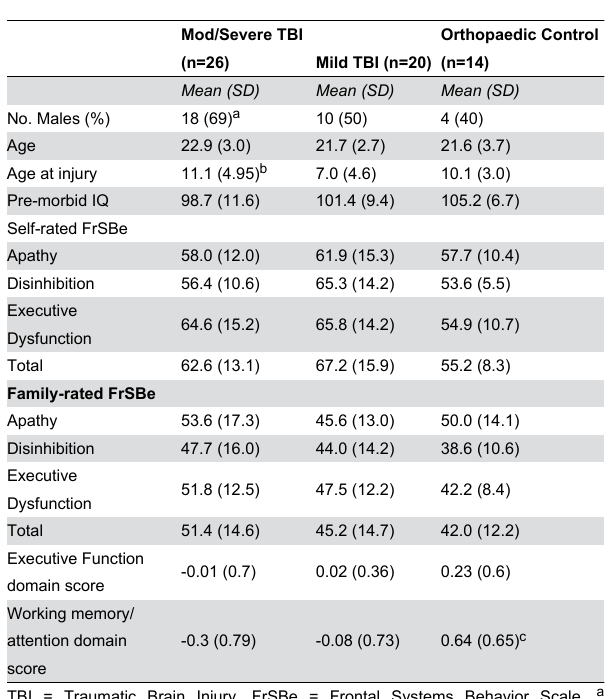
Table 2. Correlations between domain scores, self-rated, and family-rated frontal